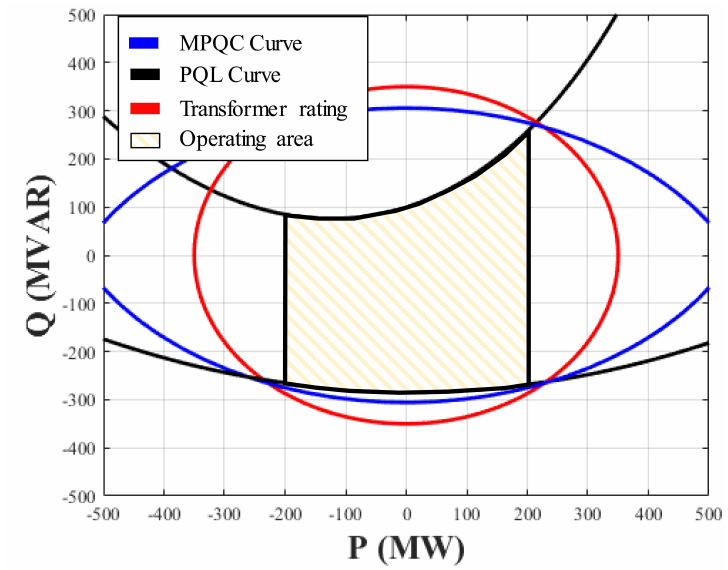
Figure 18. Representation of MMC operation range satisfying all conditions with submodule capaci- tance of 7